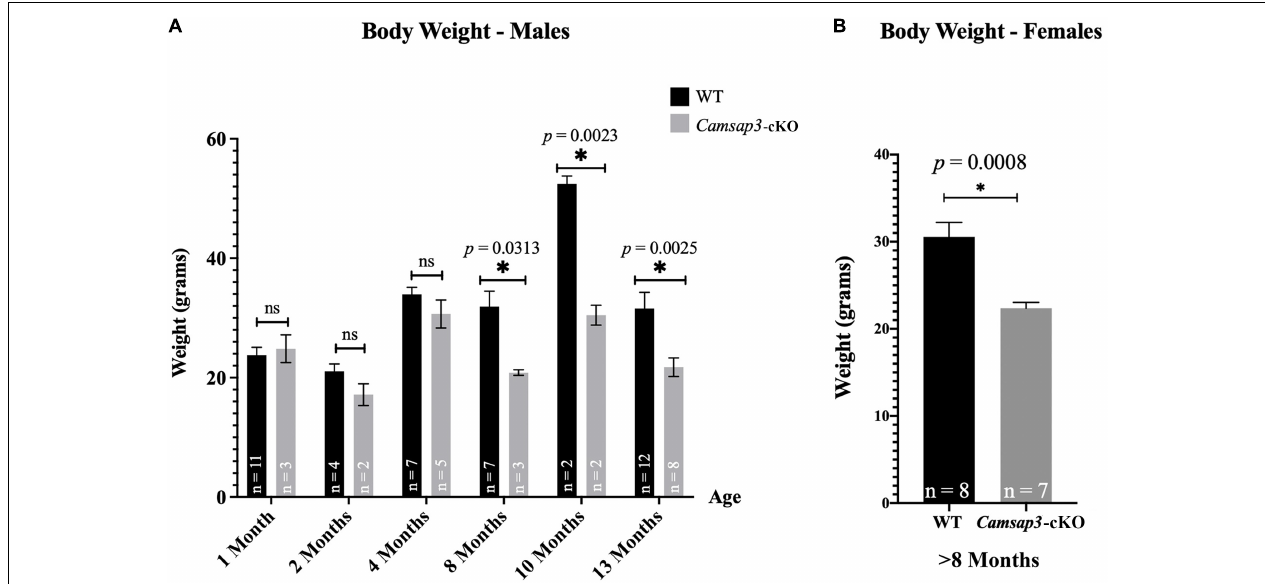
FIGURE 4 | Weight differences between WT and Camsap3 -cKO mice. (A) Male Camsap3 -cKO mice weigh less than their WT counterparts after the age of 8-month, while no body weight difference was observed in mice younger than 4-month old. Mice were weighed prior to euthanasia at ages P36–P388. ns, not statistically significant difference. (B) Female Camsap3 -cKO mice aged 8–13 months weigh less than their WT counterparts. For both male and female mice, the weights of old WT and Camsap3 -cKO mice were significantly different. p -values for each age group of mice were as indicated. *Statistically significant difference.